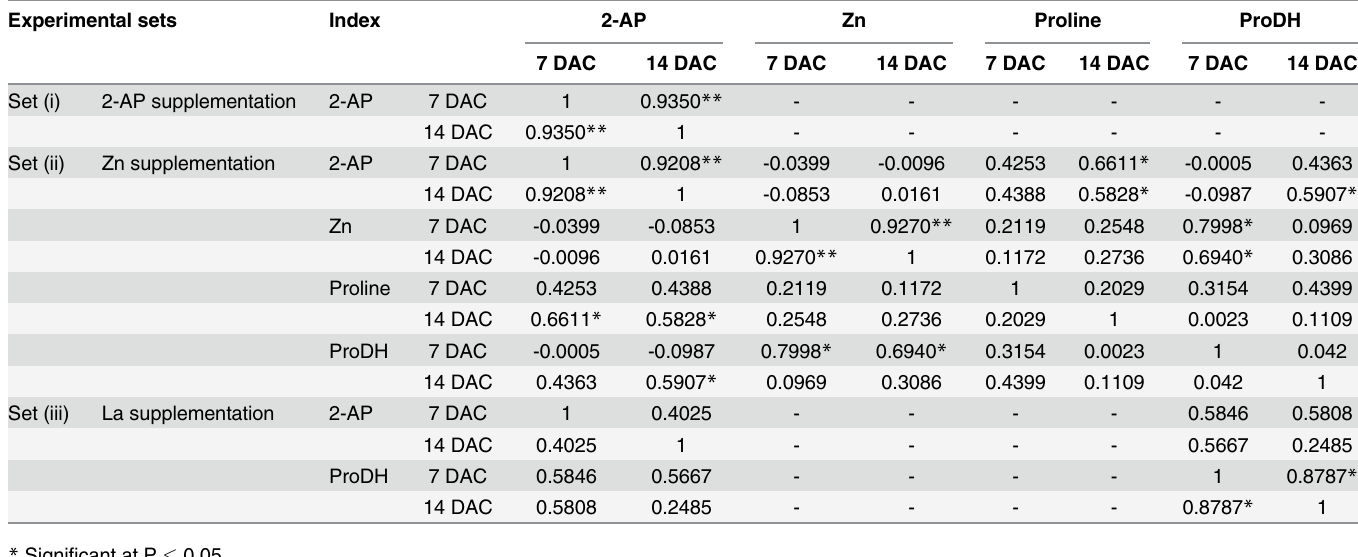
Table 3. Correlation analyses among different indices in three sets of experiments at 7 and 14 DAC of rice panicles in vitro . Experimental